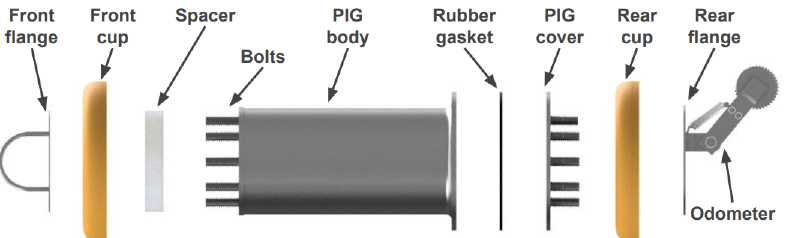
Figure 15. Exploded view of the Prototype PIG 2.